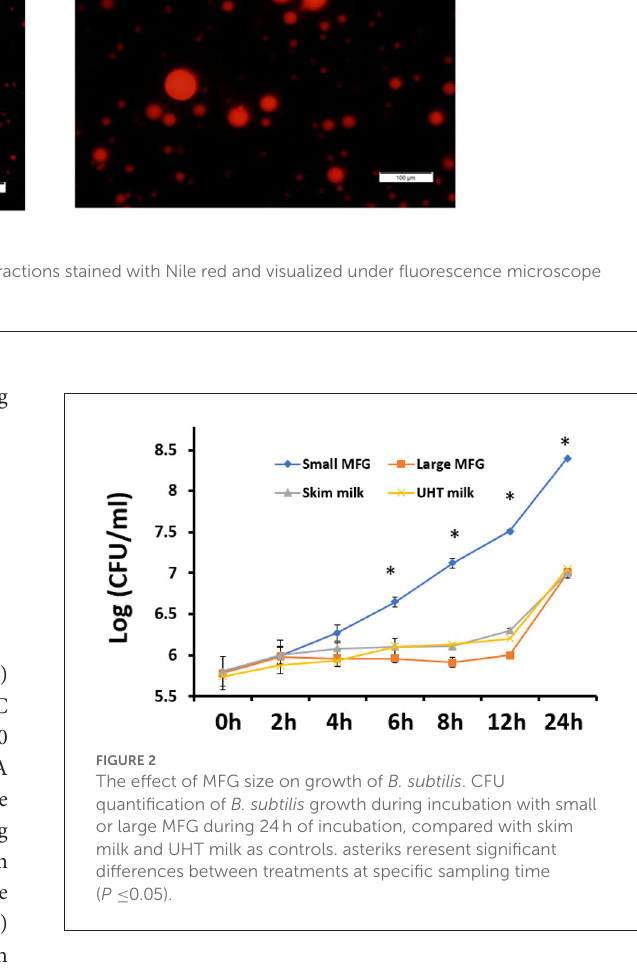
FIGURE2 The effect of MFG size on growth of B. subtilis . CFU quantification of B. subtilis growth during incubation with small or large MFG during 24h of incubation, compared with skim milk and UHT milk as controls. asteriks reresent significant differences between treatments at specific sampling time ( P ≤